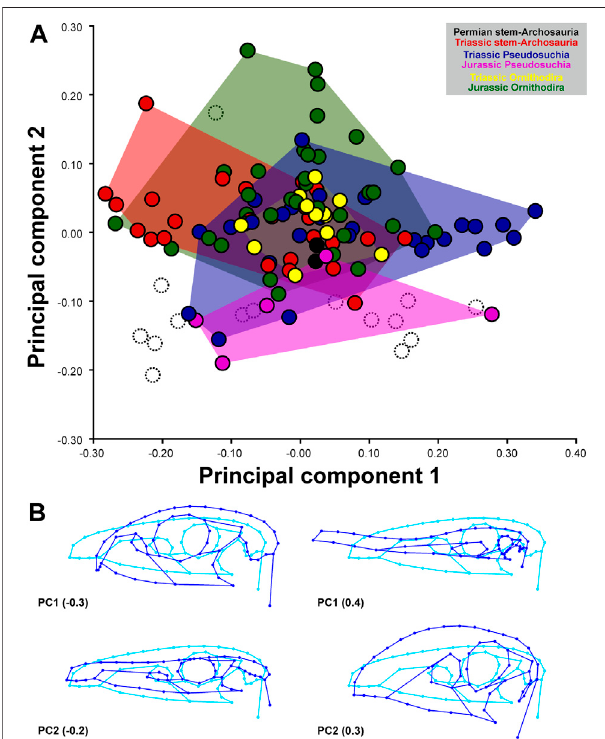
FIGURE 2 | Two − dimensional morphospace (A) and major shape variation (B) of the archosauromorph cranium captured by 2D geometric morphometrics based on the fi rst two principal components. The morphospaces (convex hulls) of stem-archosaurs, pseudosuchians and avemetatarsalians during different time periods are differently colored. White points with dashed outline represent Cretaceous taxa that have been used to estimate hypothetical ancestral shapes for the Late Jurassic. Blue wireframes show major shape variation of the principal components compared to the consensus shape shown in cyan.